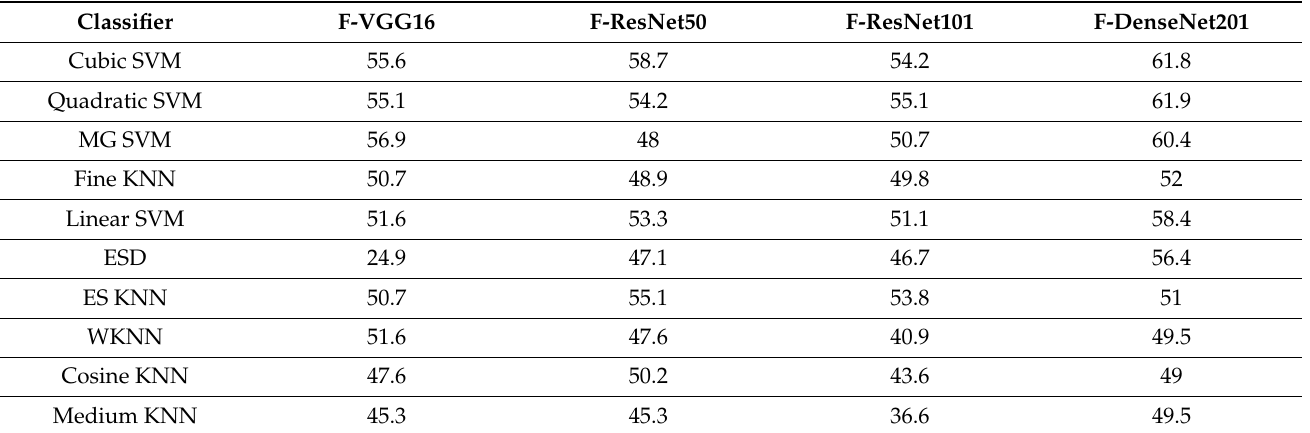
Table 2. Classification results on originally selected cucumber dataset without data augmentation step for several fine-tuned deep learning models.